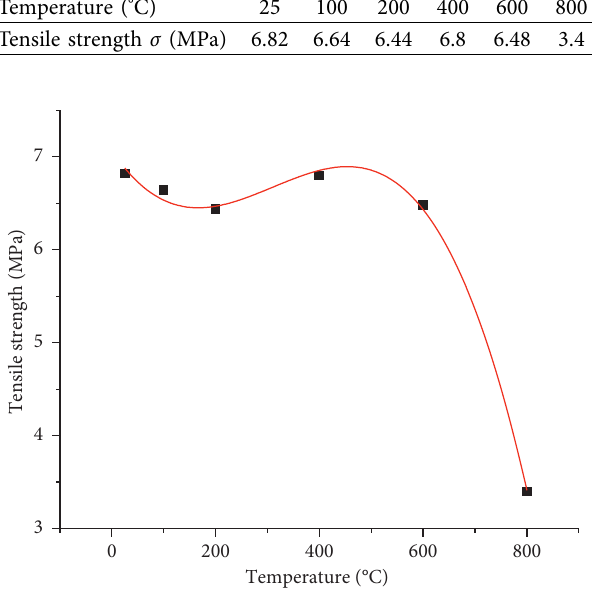
Figure 11: Tensile strength of the marble under different